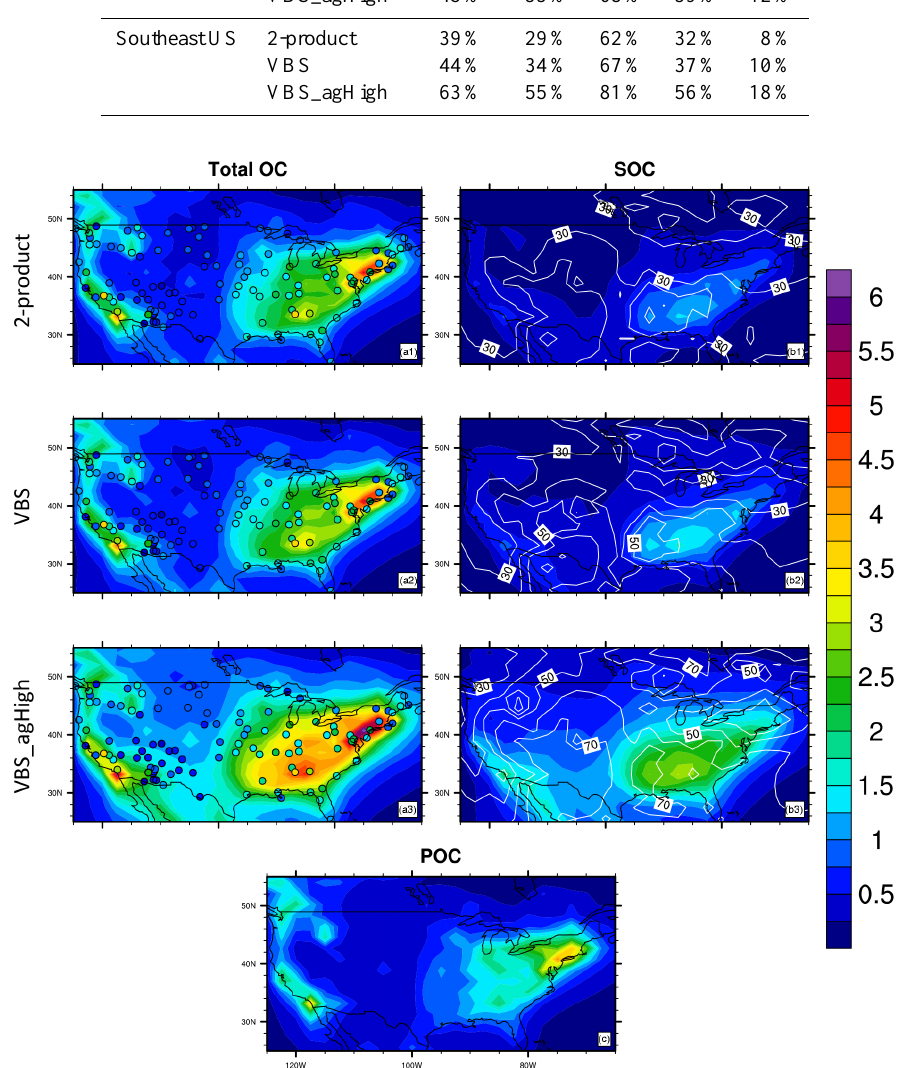
Figure 2. Annual mean surface concentrations (units: µg[C]m − 3 ) of (a1) – (a3) total organic carbon (OC = POC + SOC), (b1–b3) secondary organic carbon (SOC) and (c) primary organic carbon (POC). The data is averaged from 2005 to 2009. In (a1) – (a3) , scatters are IMPROVE observations and color shades are simulated total OC from the models 2-product, VBS and VBS_agHigh. In (b1) – (b3) , white contours indicate the fraction of SOC in total OC (%), ranging from 30 to 70% with an interval of 10%. (c) shows simulated POC, which is identical in the three